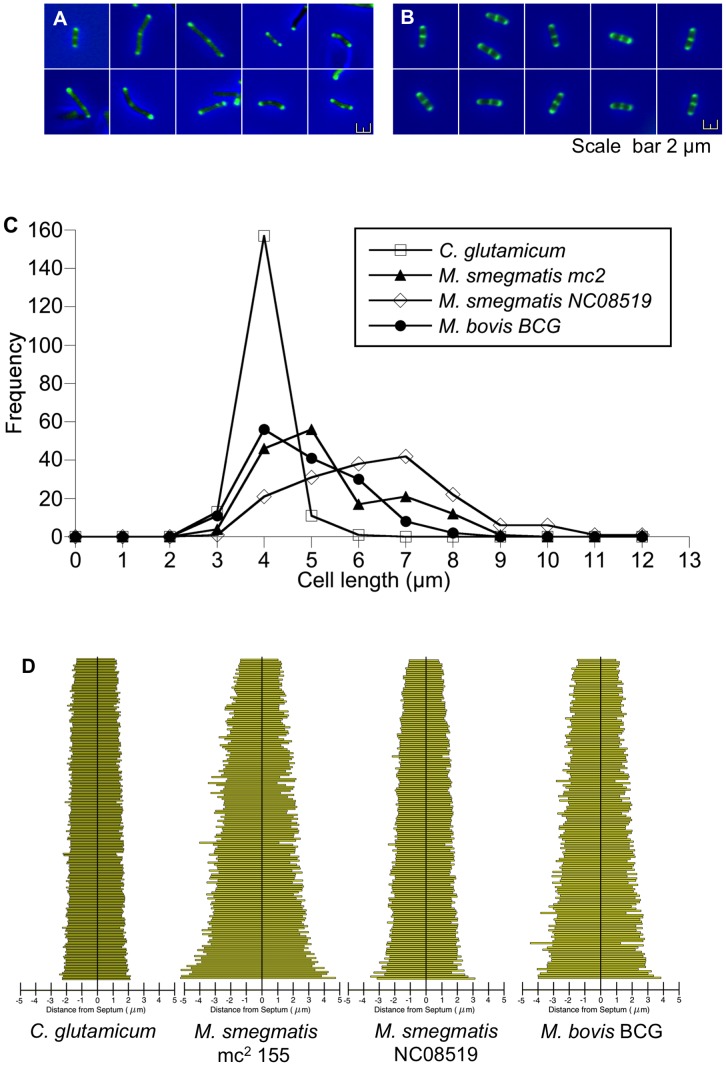
Internal spot placement and cell length are more variable in mycobacteria compared to C. glutamicum
. (A) M. smegmatis mc2 155 cells with two polar and one internal spots of VanBODIPY staining; note variable cell lengths and eccentric internal spot placement. (B) C. glutamicum cells with three spots are of similar size with a centrally located internal spot. Scale bar = 2 µm. (C) Plotting cell length versus frequency for 3-spot cells (n = 148) from all three species of bacteria, shows there is significantly more cell length variability in mycobacterial populations compared to C. glutamicum (p<0.01 Wilcoxon signed-rank test). (D) More than 95% of C. glutamicum cells contain an internal spot within the central 20% of the cell length, compared to only 70% of mycobacteria. Data for 3-spot cells was collected from three independent experiments.